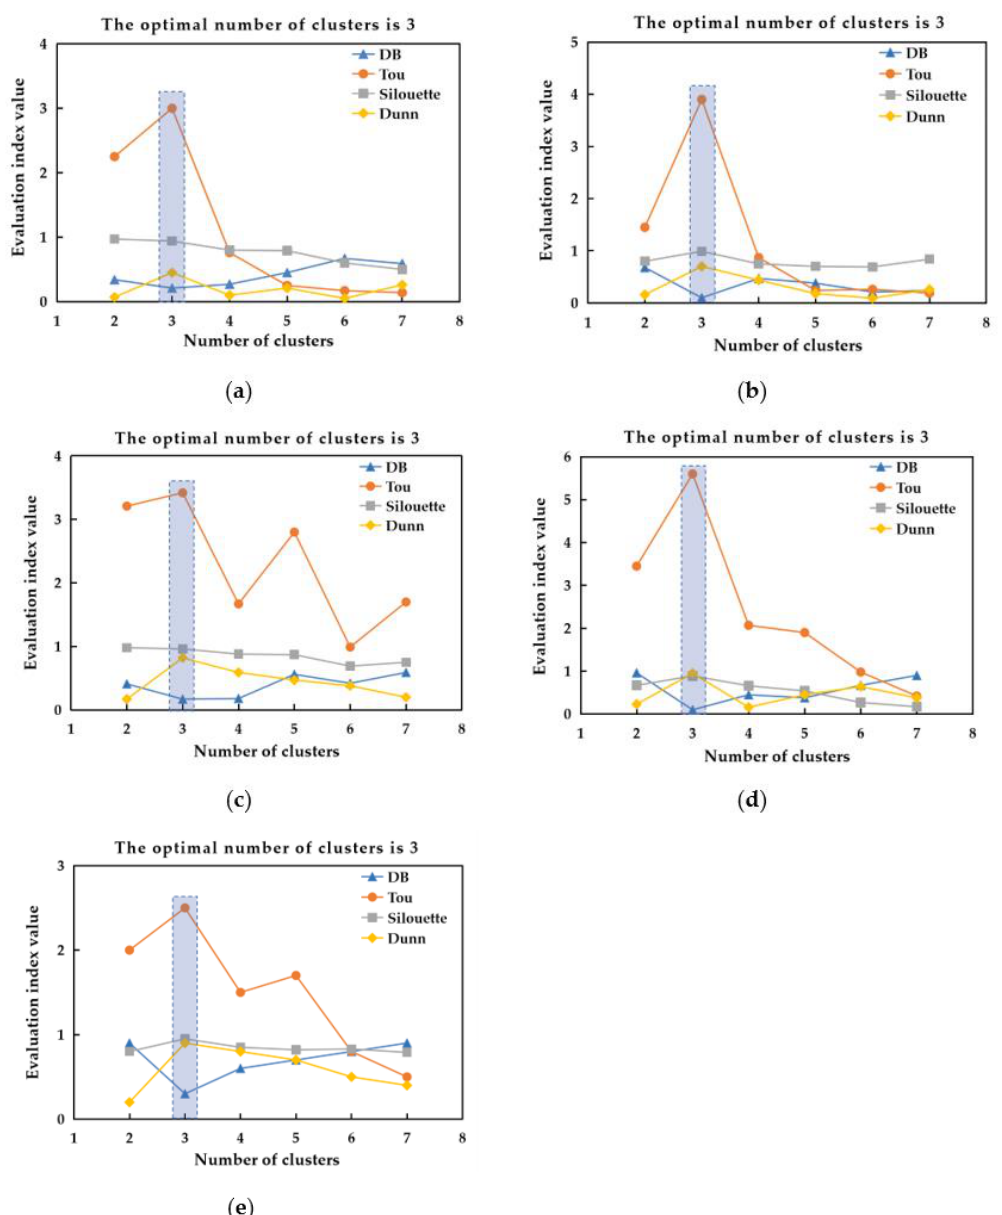
Figure 5. Clustering evaluation index results of five common clustering methods: ( a ) k-means clustering; ( b ) FCM clustering; ( c ) GMM clustering; ( d ) SOM clustering; ( e ) hierarchical clustering.